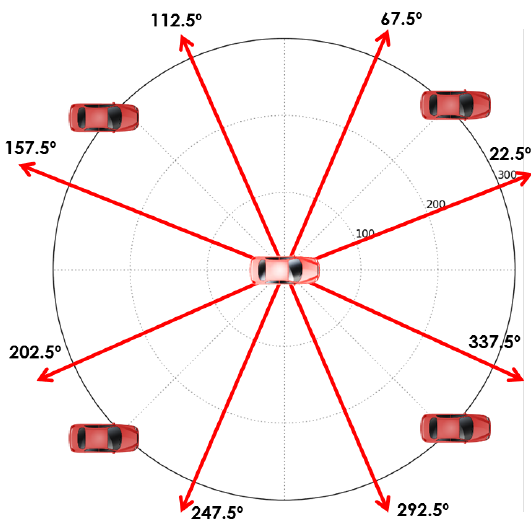
Figure 4. Node selection. In this example, n = 4 and k =